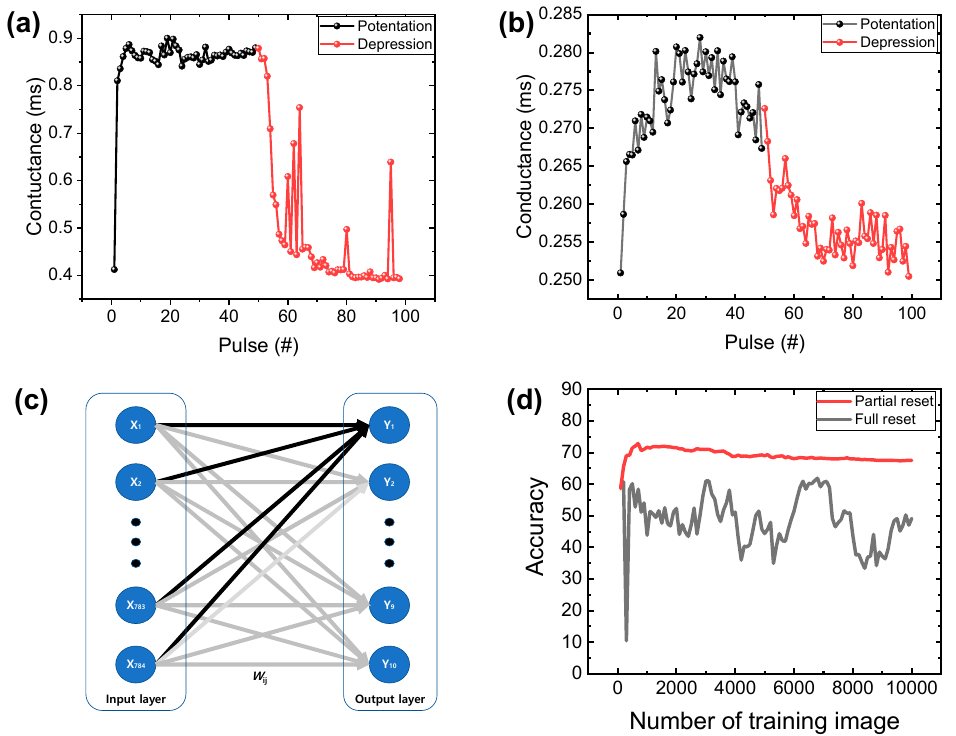
Figure 5. Potentiation and depression characteristics for ( a ) full reset mode and ( b ) partial reset mode. ( c ) Neural network for neuromorphic simulation. ( d ) Pattern recognition accuracy when using full reset mode and partial reset mode as synaptic weight in neural network.